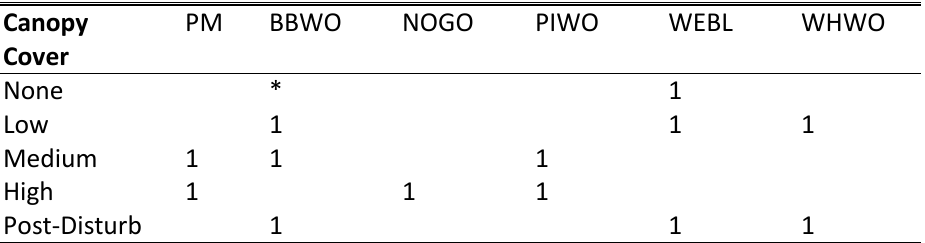
Table A8.3. Scores for species canopy layering Canopy AM BBWO NOGO PIWO WEBL WHWO Layering